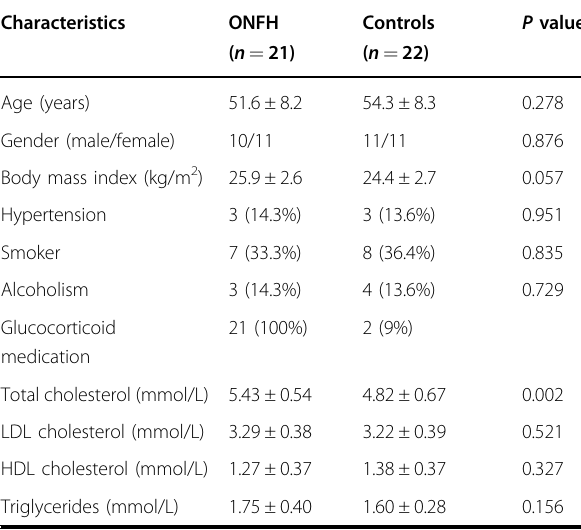
Table 1 Clinical Characteristics of the subjects